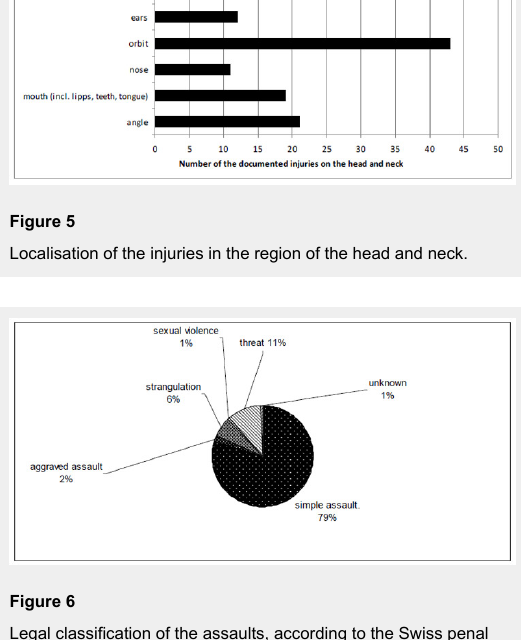
Legal classification of the assaults, according to the Swiss penal